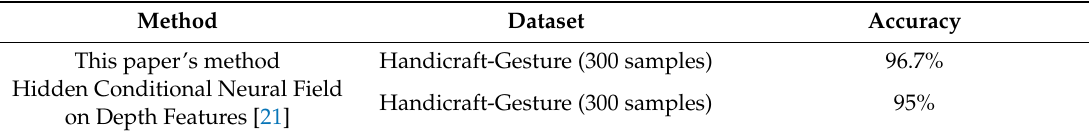
Table 7. Comparison of the accuracy among significant works on the Handicraft-Gesture dataset.